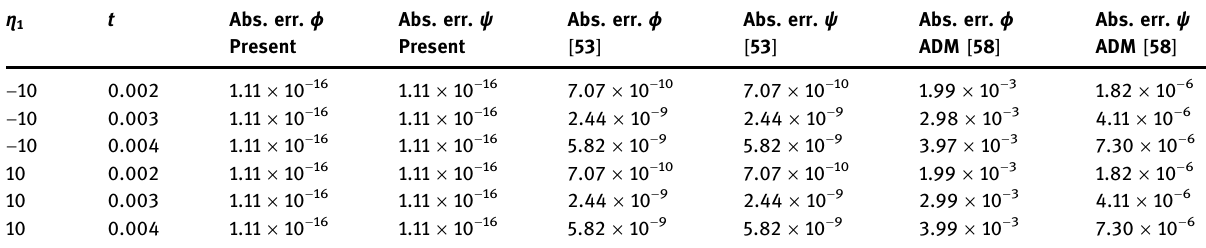
Table 1: Comparison of absolute errors regarding Example 1 η 1